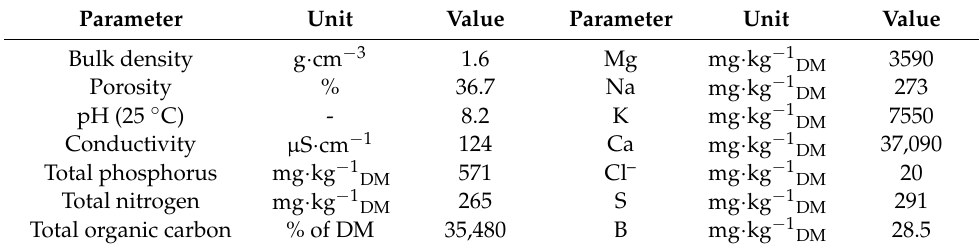
Table 3. Qualitative description of irrigated soil at the beginning of the